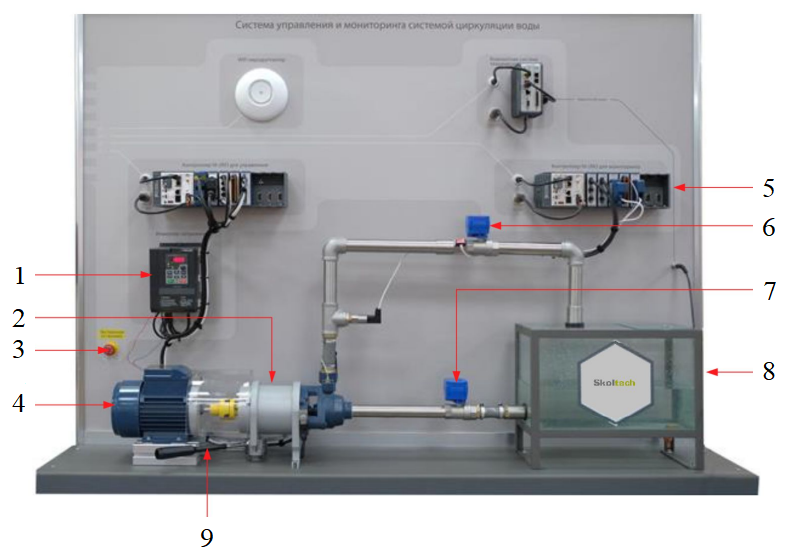
Figure 10. Skoltech Anomaly Benchmark ( SKAB ) testbed. Figure obtained from [44]. 1,2—solenoid valve; 3—a tank with water; 4—a water pump; 5—emergency stop button; 6—electric motor; 7—inverter; 8—compactRIO; 9—a mechanical level for shaft